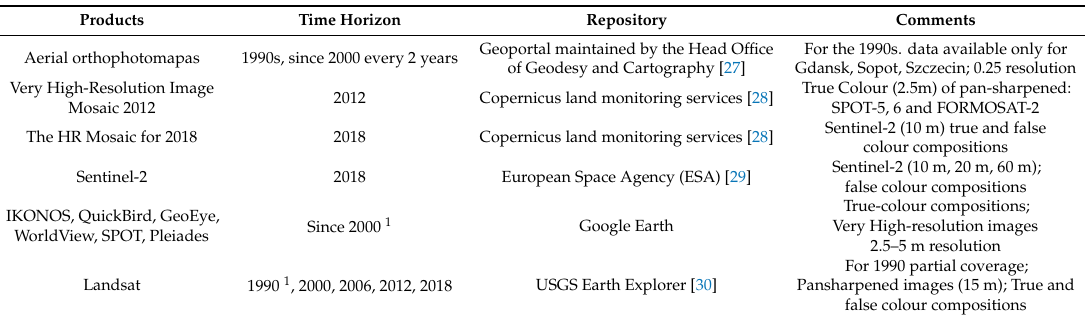
Table 4. Satellite and aerial imageries used for CLC change